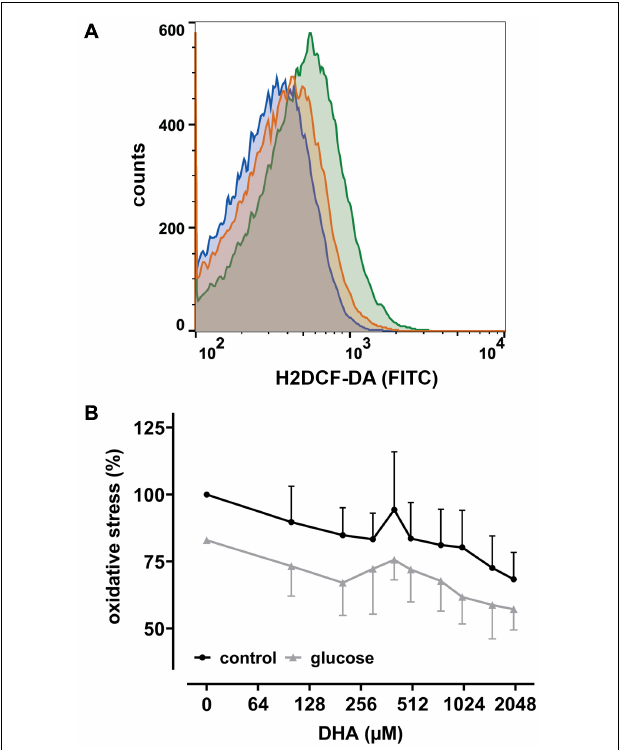
FIGURE 2 | DHA and glucose lower intracellular levels of reactive oxygen species (ROS). (A) Histogram depicting quantitative changes of ROS in erythrocytes treated with 2 mM DHA in the presence (blue) or absence (orange) of 5 mM glucose or PBS only (green). (B) Erythrocytes ( n = 6) loaded with 2 (cid:48) ,7 (cid:48) -dichlorodihydrofluorescein-diacetate (H2DCF-DA) were treated with various amounts of DHA for 15 min in the presence (gray) or absence (black) of 5 mM glucose at RT and processed for flow cytometry. Mean fluorescence intensity (MFI), reflecting intracellular ROS, is given in percent after normalization to the MFI of PBS control cells (set to